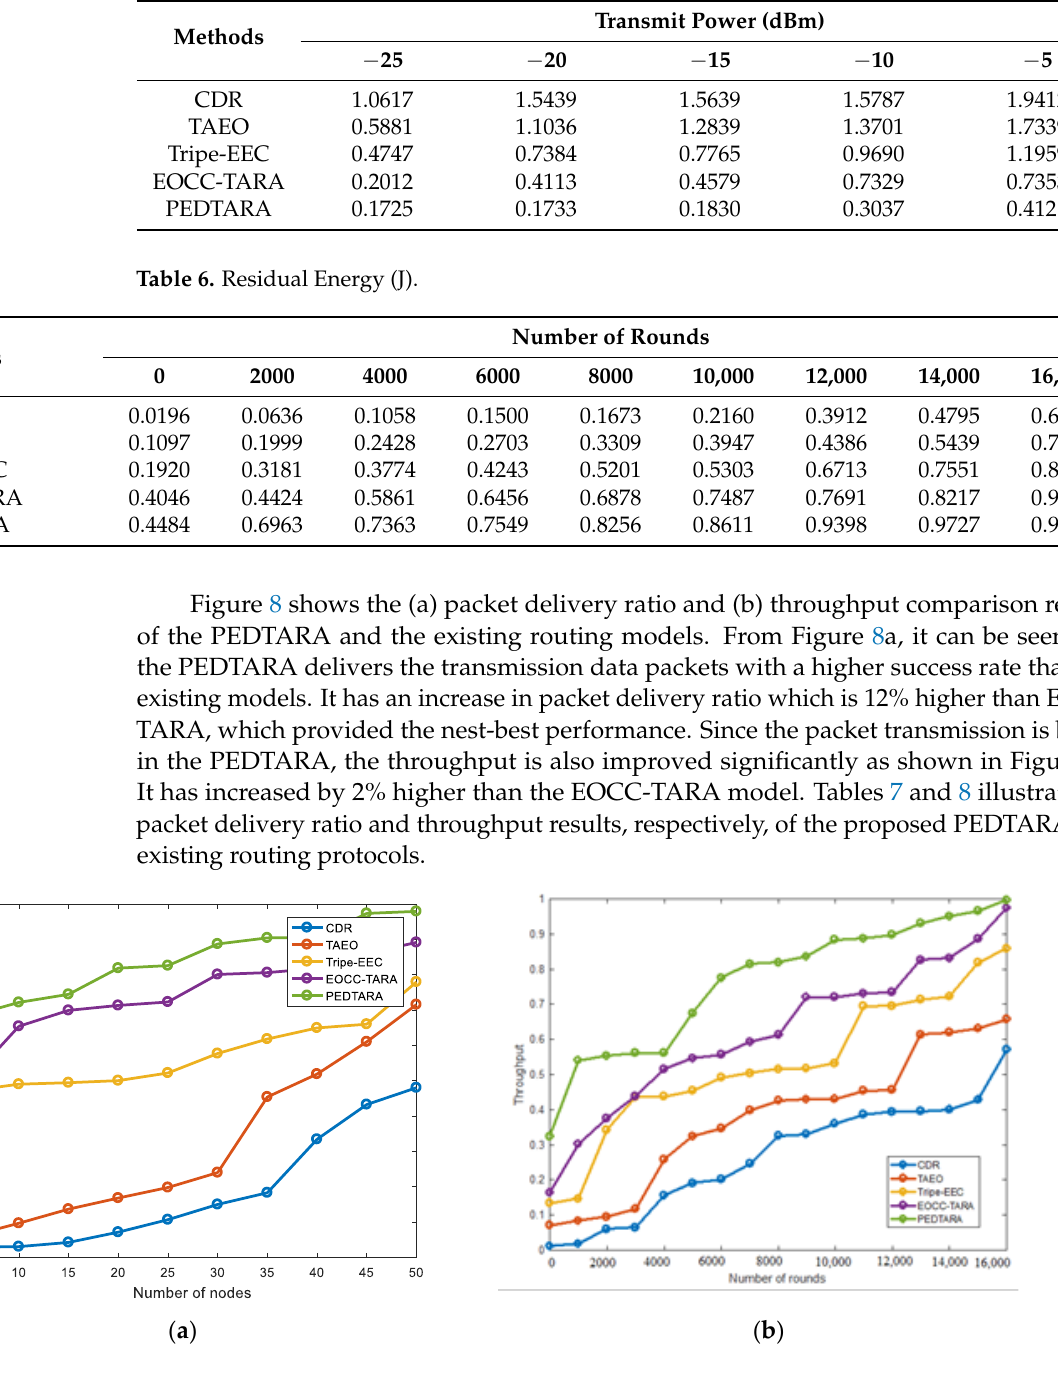
Figure 8. Packet delivery ratio and throughput comparisons: ( a ) packet delivery ratio; ( b ) through- put. Table 7. Packet delivery ratio (%).